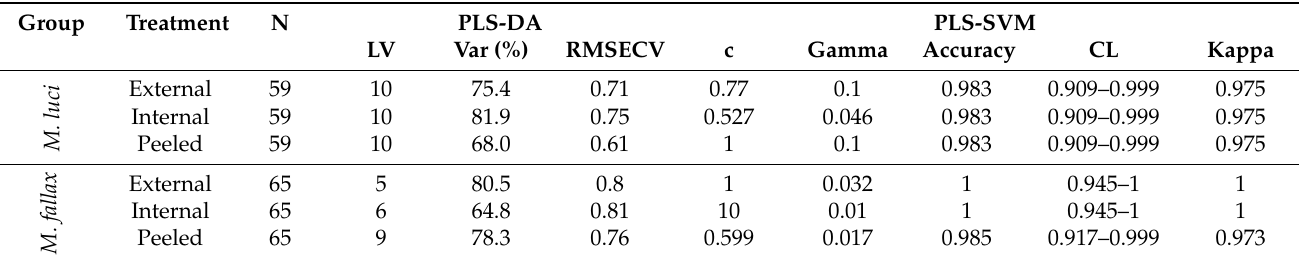
Table 2. Partial least squares discriminant analysis (PLS-DA) and partial least squares support vector machine (PLS-SVM) results for all experiments to detect Meloidogyne luci and M. fallax in potato tubers using hyperspectral imaging. LV: number of PLS latent variables; N: number of tubers; Var (%): amount of variance explained by the selected LVs; RMSECV: root mean squared error of cross-validation; CL: 95% confidence limits.